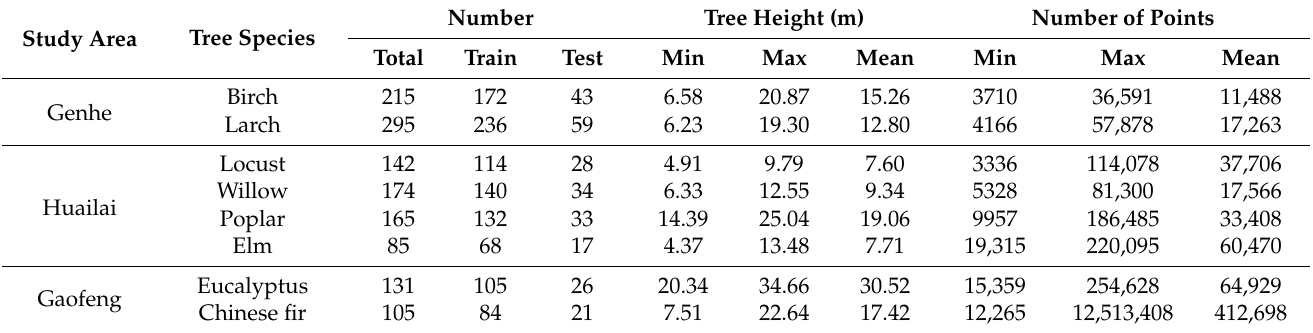
Table 2. Basic point cloud data of tree species.